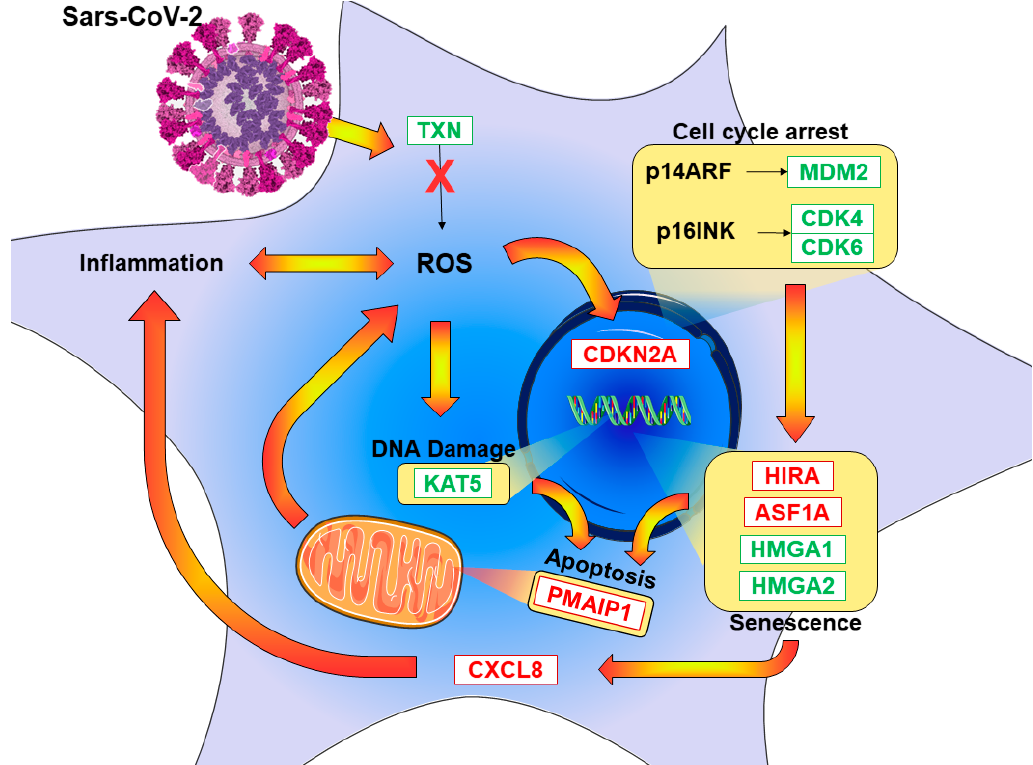
Figure 6. SARS-CoV-2-triggered pathway depiction of DEGs found in RNA-seq analyses after infection of the HCN-2. The red genes are upregulated and, thus, more expressed after the infection. The green downregulated genes are more expressed in the control. The yellow frames show increased activities.